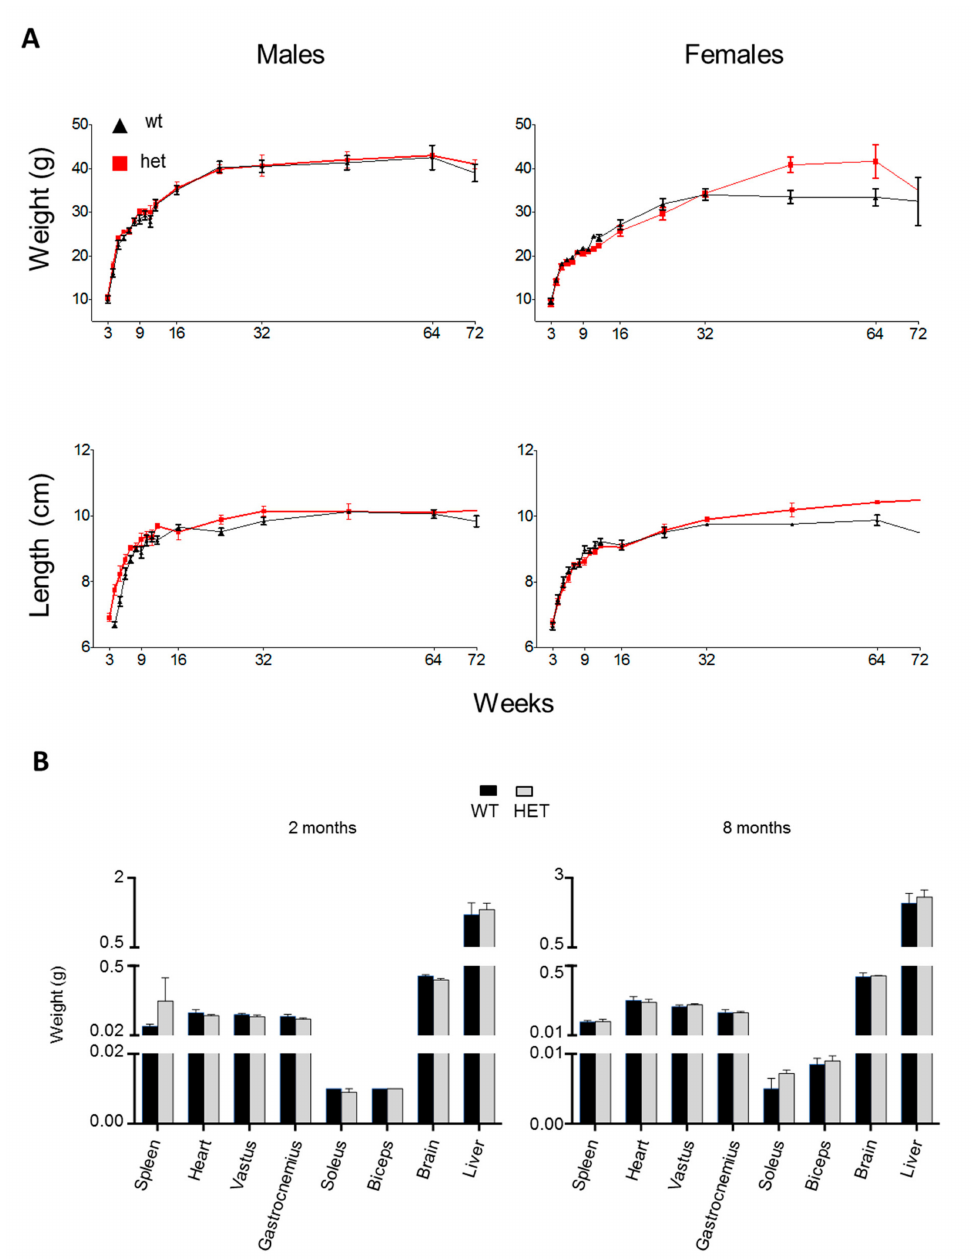
Figure 1. Phenotypic characterization of Lonp1 wt / − mice. ( A ) Average weight and length of the body of heterozygous (het) (red line) and wild type (wt) (black line) mice. Measures started from the third week of life and were repeated every week until the 12th week, then at 4, 6, 8, 12, 16 and 18 months. Length was measured from nose to base of tail. Data are expressed as mean ± SEM of at least three di ff erent animals. ( B ) Analysis of weight of di ff erent organs and tissues. Measurements were taken after the organs explant in 2- and 8-months old mice. Data are expressed as mean ± SEM; n = 5 or